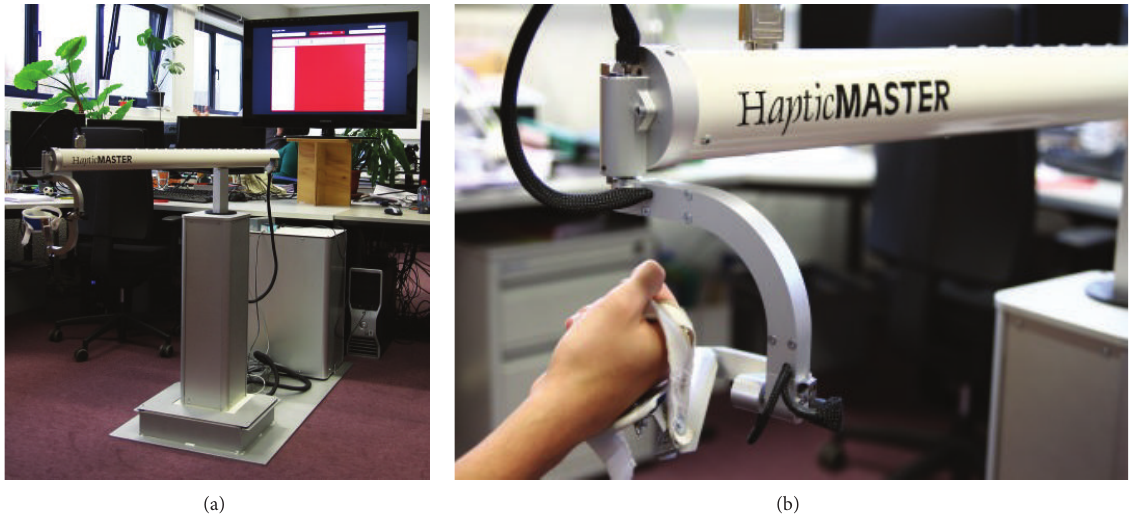
Figure 2: I-TRAVLE hardware system: MOOG HapticMaster and visual display (a), ADL gimbal (b).